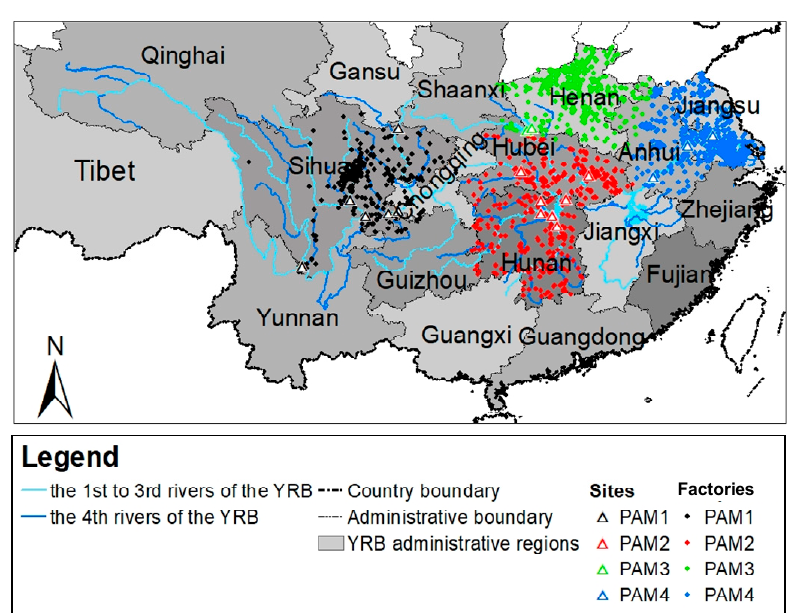
Figure 2. Spatial partitioning around medoids (PAM) clustering of the 18 surface water sites and the 2213 wastewater-generating factories (also their 2386 monitored sewage outlets) in the Yangtze River Basin in 2016 and 2017.